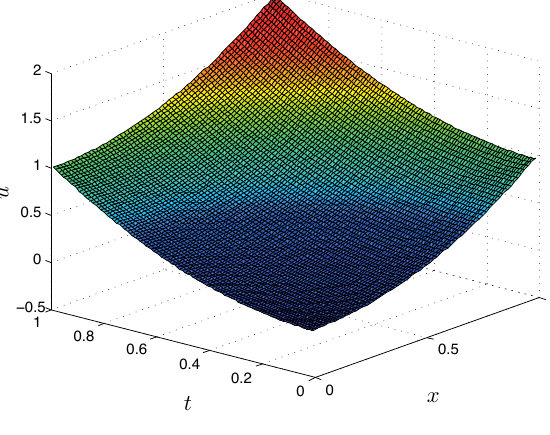
Fig. 7. Plot of the numerical solution for Test Problem 9.